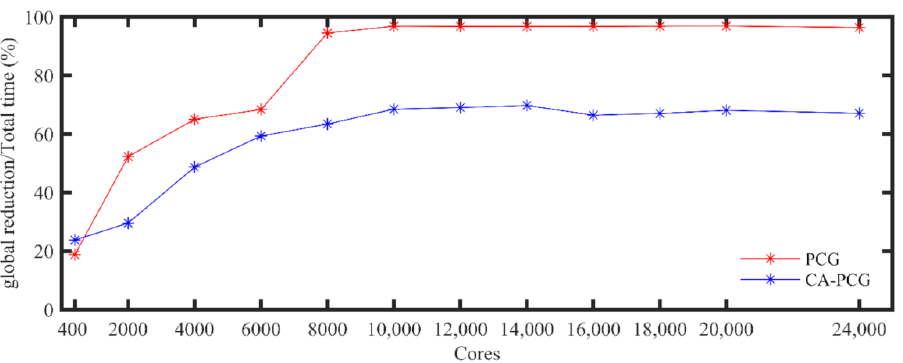
Figure 5. Percentages of the global reduction (MPI_Allreduce) time of the total execution time in 5-km Nucleus for European Modelling of the Ocean (NEMO) experiments using the preconditioned conjugate gradient (PCG) (blue line) and CA-PCG (red line) solvers.